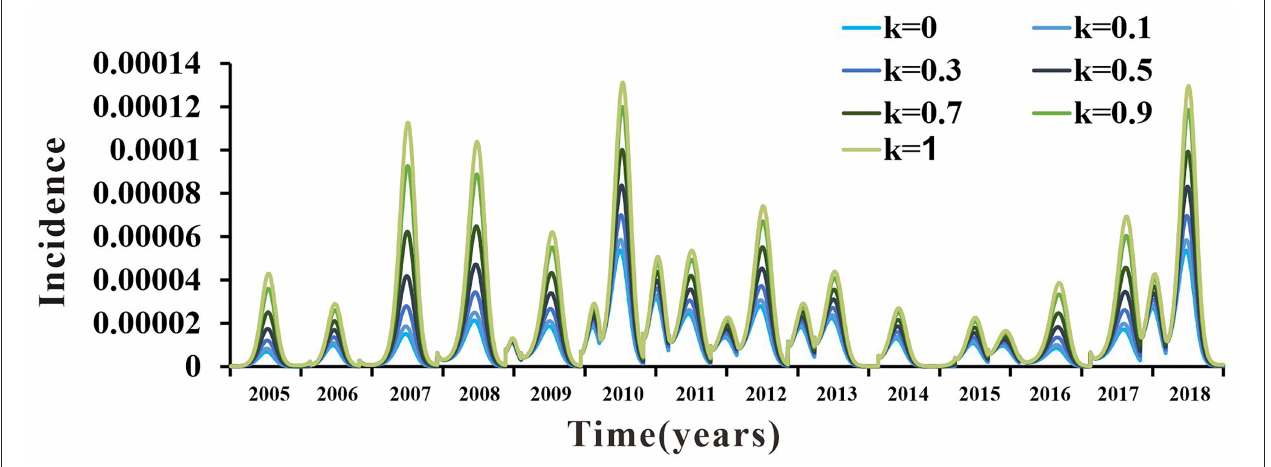
FIGURE 9 | Sensitivity analysis